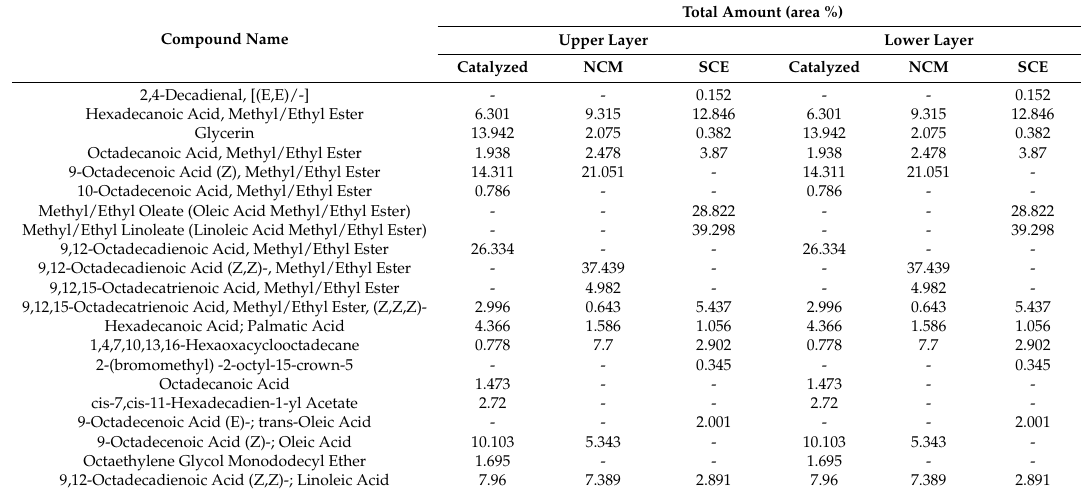
Table 6. Components obtained from the catalyzed and supercritical processes of WCO in terms of area % as obtained from GC